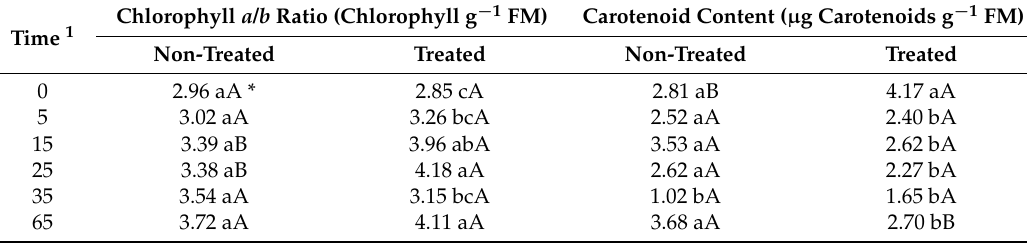
Table 1. Chlorophyll a/b ratio and total carotenoid content in the cultivar,